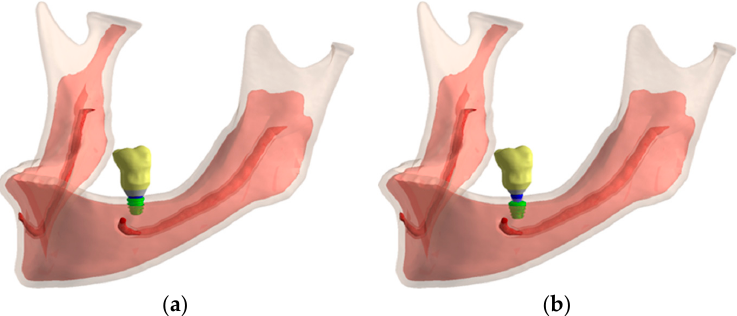
Figure 5. Cortical and trabecular bone geometry: ( a ) IH connection; ( b ) MT connection.